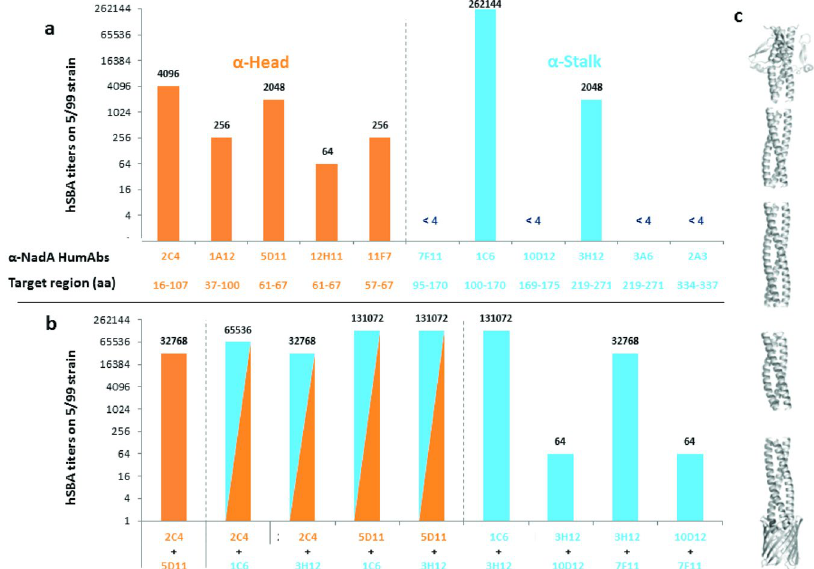
Figure 5. Functionality of anti-NadA mAbs assessed by the Serum Bactericidal Activity Assay Human serum bactericidal assay 27 titers obtained with single mAbs ( a ) or combinations ( b ) targeting NadA head (orange) or stalk (blue). NadA tridimensional structure 21 . ( c ) Threshold for positive titer was defined as > 4, antibody couples are considered cooperative if the titer obtained with mAbs combination is at least fourfold higher than titer obtained with single mAbs. * Coordinates of the epitope recognized by each mAb on the NadA variant 3